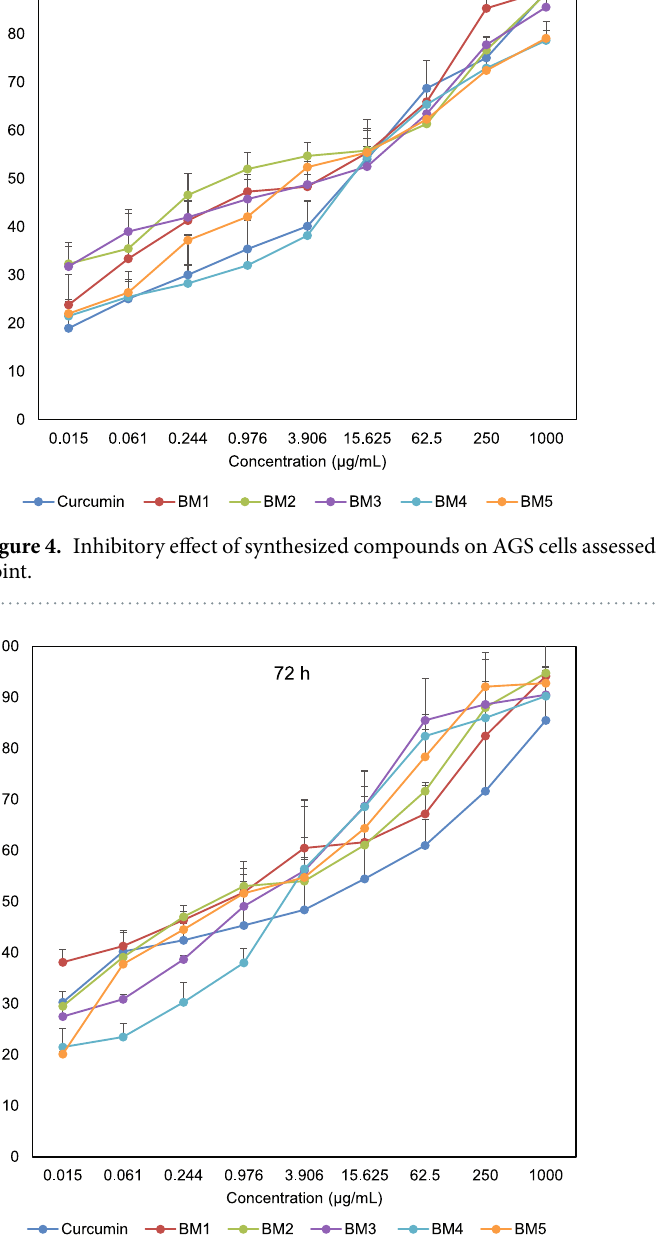
Figure 5. Inhibitory effect of synthesized analogues on AGS cells determined by MTT assay after 72 h time